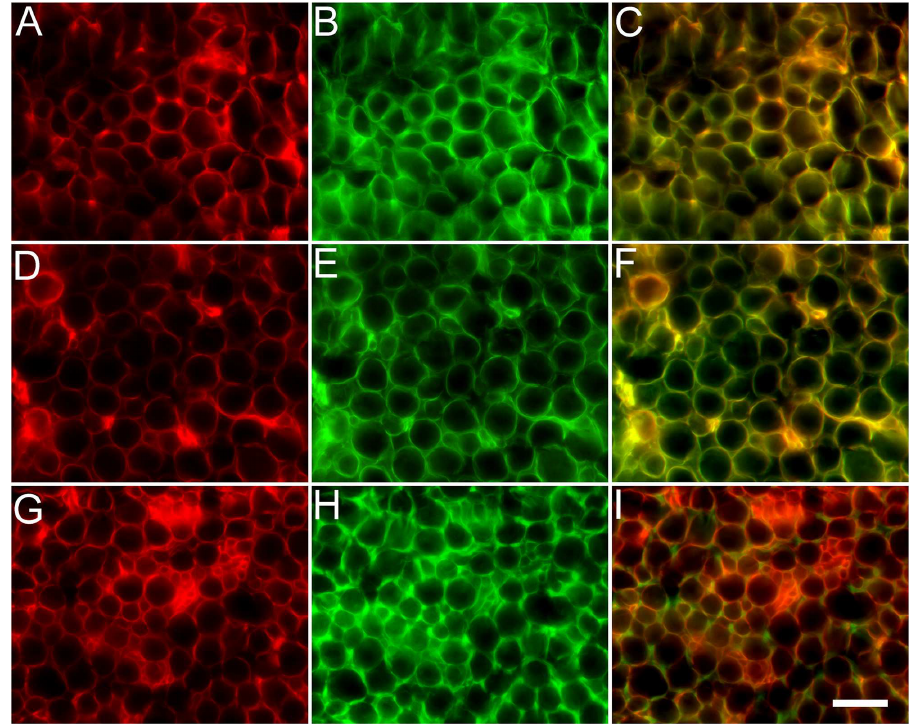
Fig 3. Perlecan distribution relative to laminin, Δ CS-A, and Δ CS-C in normal rat peripheral nerve. Normal rat sciatic nerve was subjectedto chondroitinaseABC treatment and immunolabeled with antibodies againstperlecanand lamininor Δ CS-C or Δ CS-A. (A) Perlecanwas present within the endoneurium tubes and appearedto label the ring-likestructures in a similar pattern to laminin(B). (C) Combinationof filters revealed that both lamininand perlecanclosely associate within the basal lamina tubes. (D) Perlecanalso closely associated with Δ CS-C tubes (E) which was confirmedwhen filters were merged (F). (G) Perlecan did not colocalizewith Δ CS-A (H) within the endoneurium and the combination of both filters clearly demonstrated a complementary distribution (I). Scale bar: 20 μ